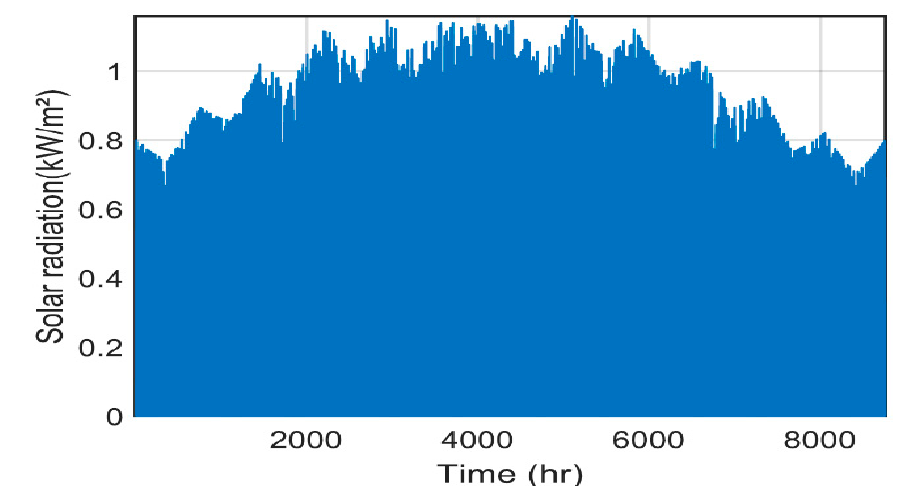
Figure 5. Annual load curve over a time interval of one hour with a peak demand of 70 kW.